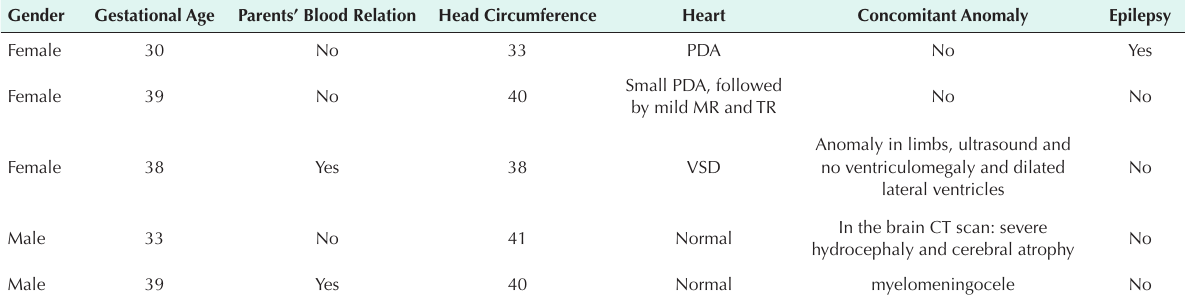
Table 1. Patients’ Hydrocephaly Description